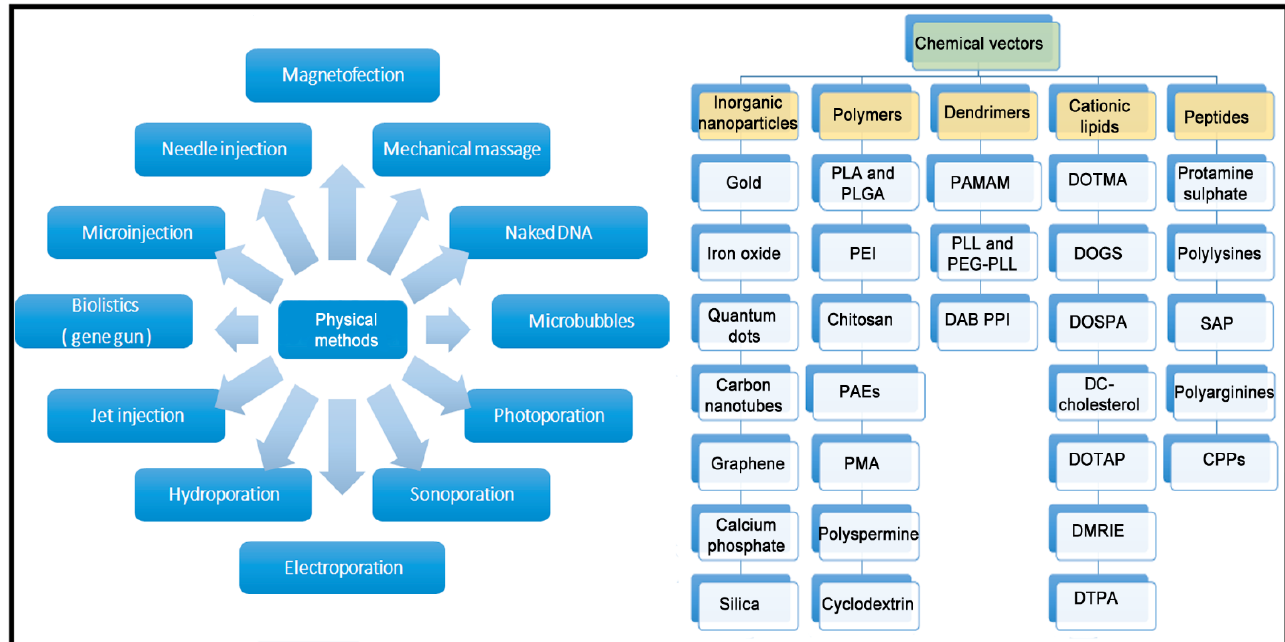
Figure 2. Overview of main physical and chemical methods of non-viral vectors.